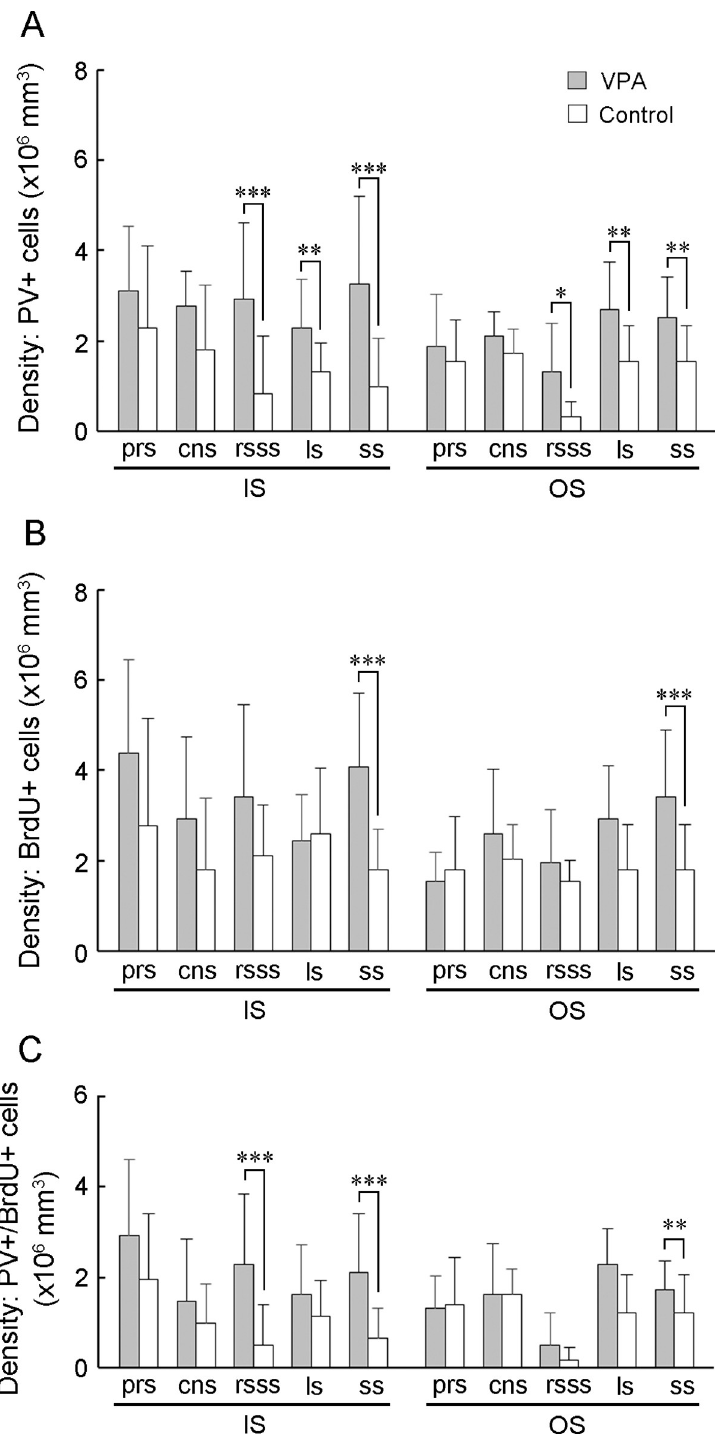
Fig 4. PV-positive, BrdU-labeled, and PV-positive/BrdU-labeled cell density in the sulcal floors of the cerebral cortex of VPA-treated and control ferrets at PD 20. (A) PV-positive neuron density. (B) PV-positive/BrdU-labeled cell density. (C) BrdU-labeled cell density. Data are shown as mean ± SEM. Significance is indicated using Scheffe’s test at � P < 0.05, �� P < 0.01, or ��� P < 0.001; number of cerebral hemispheres = 8. cns, coronal sulcus; IS, inner stratum; ls, lateral sulcus; rsss, rostral suprasylvian sulcus, ss, splenial sulcus; OS, outer stratum; prs, presylvian sulcus.